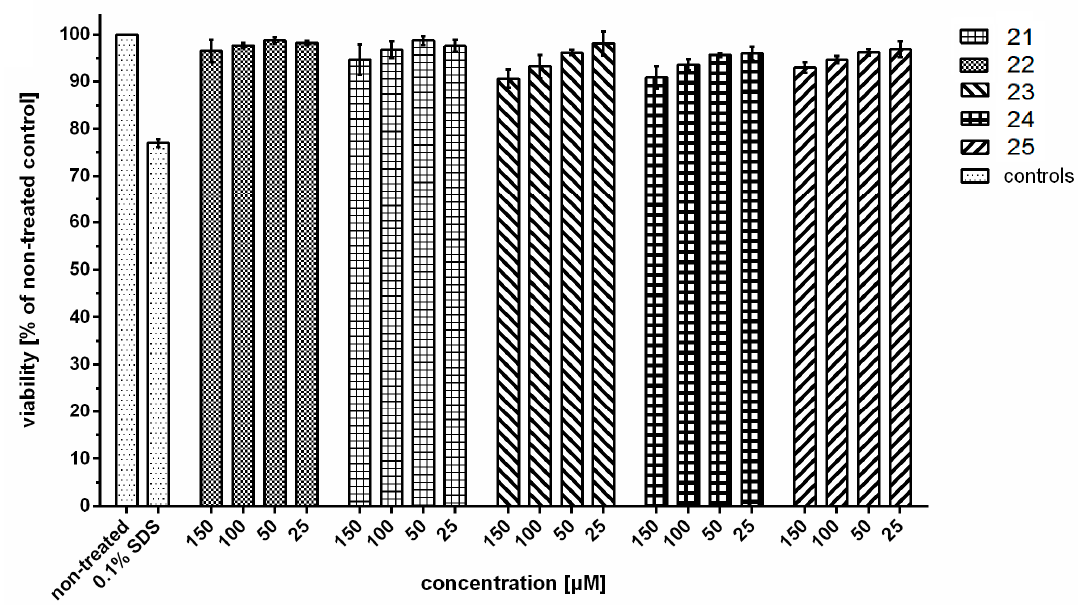
Figure 6. Cytotoxicity profile of amphiphiles 21–25 determined by 3-(4,5-dimethylthiazol-2-yl)-5-(3-carboxymethoxyphenyl)-2-(4-sulfophenyl)-2 H -tetrazolium (MTS) assay in A549 cells 24 h post treatment. Each bar represents the mean value of three independent experiments ( n = 3) measured in triplicate with SEM.